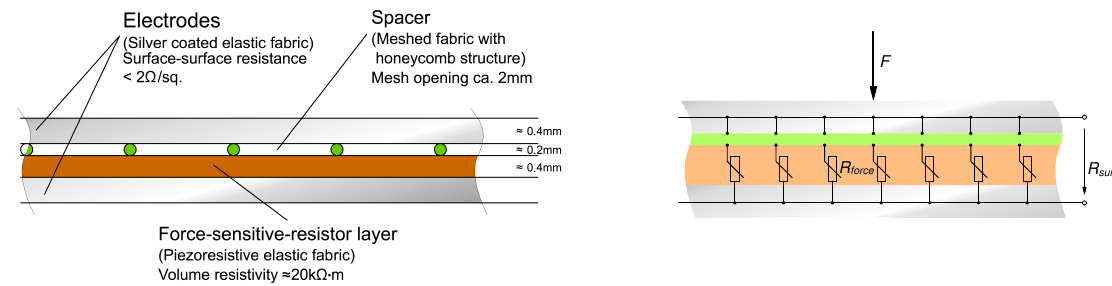
Figure 6. Schematic representation of the fabric-based tactile sensor: Two highly conductive electrode layers (silver) enclose a piezo-resistive layer (orange), measuring changes in its resistivity. The mesh layer, pictured in green, guarantees high resistance (G Ω range) during no-contact idle state. When contacts are established between the electrode and piezo-resistive layer, the sensor acts as parallel circuit of force sensitive